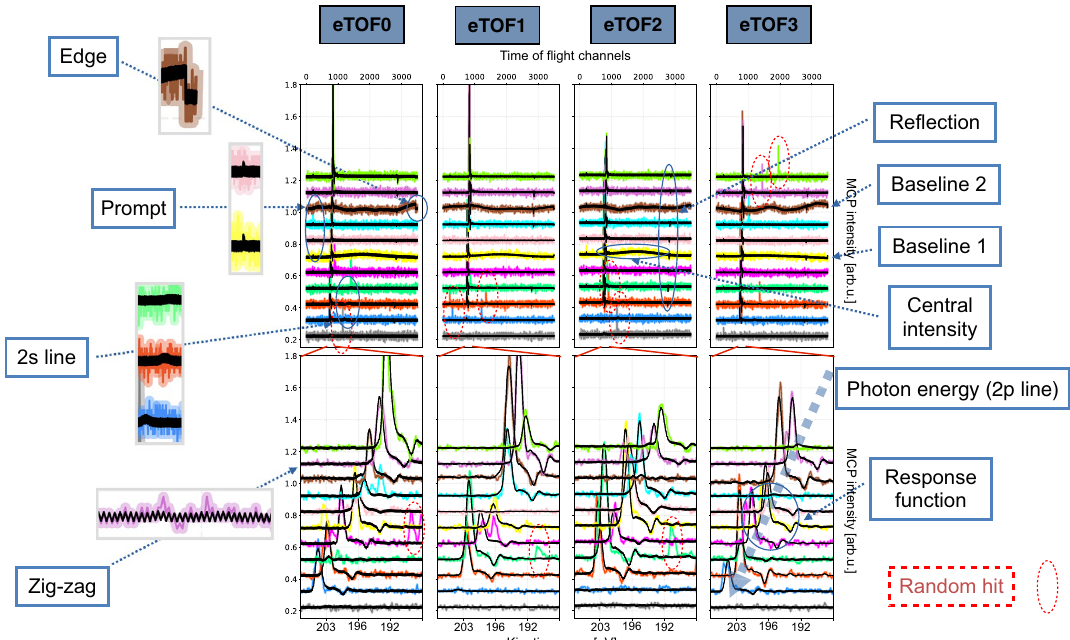
Figure 1. Eleven representative single-shot time-of-flight spectra (samples) obtained by the four OPIS electron spectrometers (eTOF 0–3): The grey traces at the bottom show no photo electron signal, whereas the other ten traces above contain Ne 2p photoelectron lines with successively longer time-of-flights, indicating decreasing FEL photon energy. The raw data is shown by coloured bold plots while the reconstruction of the corresponding samples is depicted by black thin lines. For better visibility the base lines are separated by a vertical offset of 0.1. The four upper panels show the full electron time-of-flight spectra, which is the input of the neural network, while a zoom-in of the corresponding region of interest, where the 2p line is expected, is presented in the lower four panels. The zoom-in axis is converted to kinetic energy of the photoelectron. Main features of the traces are labelled, such as peak position, random hits, baseline disturbances, a zig–zag structure, the prompt, 2s and 2p line, electronic reflection due to impedance mismatch on cable connection and the corresponding detector response function. These are reconstructed (apart from the random hits) and encoded in the latent space. The magnified insets represent features that are difficult to see in full scale. All scales are